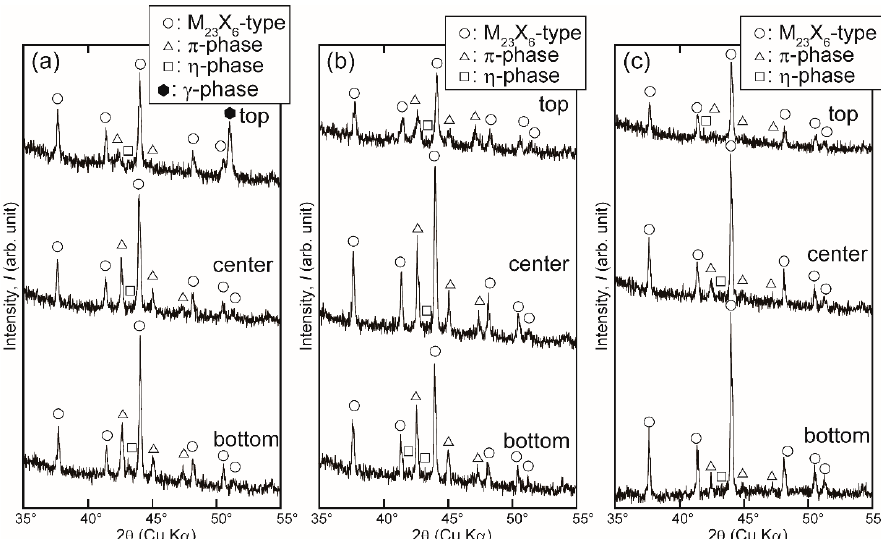
Figure 6. X-ray diffraction (XRD) patterns of the precipitates electrolytically extracted from the ( a ) as-built, ( b ) aged, and ( c ) reversely transformed specimens of the high-C alloy.